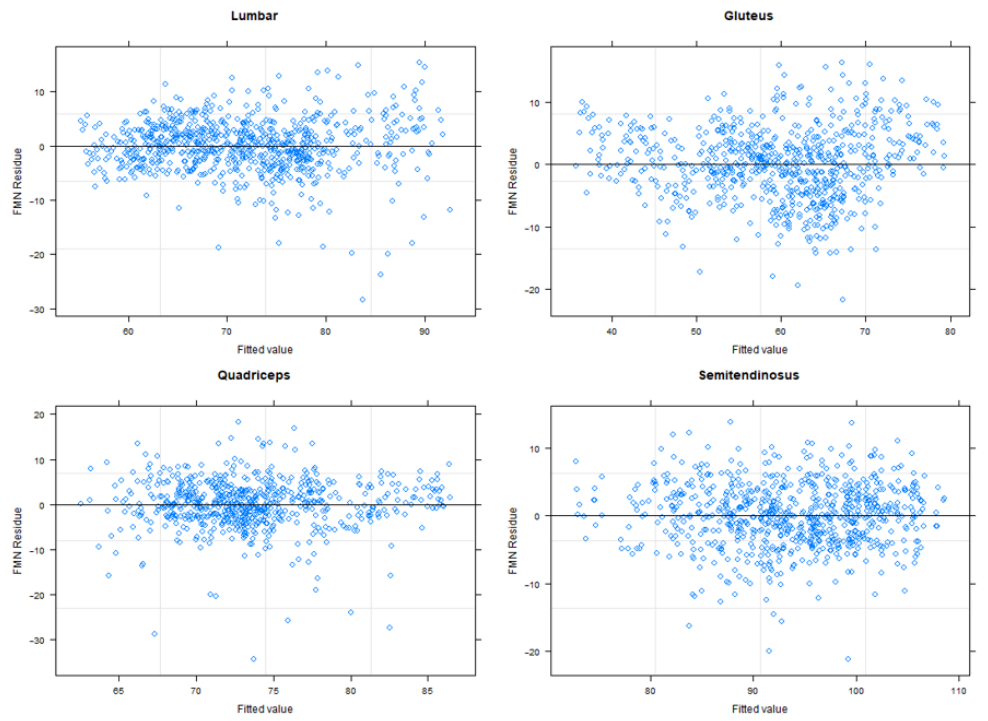
Figure A3. Plot of residues, fitted values minus observed values, over the fitted values for FMN for each muscle mixed model.